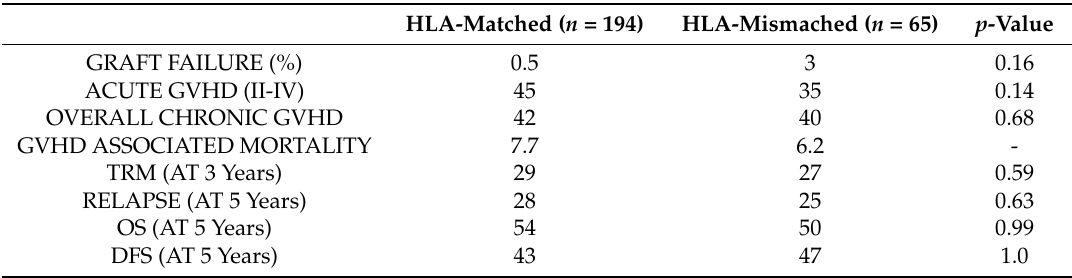
Table 2. Comparison of rates of GVHD, TRM, relapse and survival among HLA-matched and mismatched unrelated grafts receiving